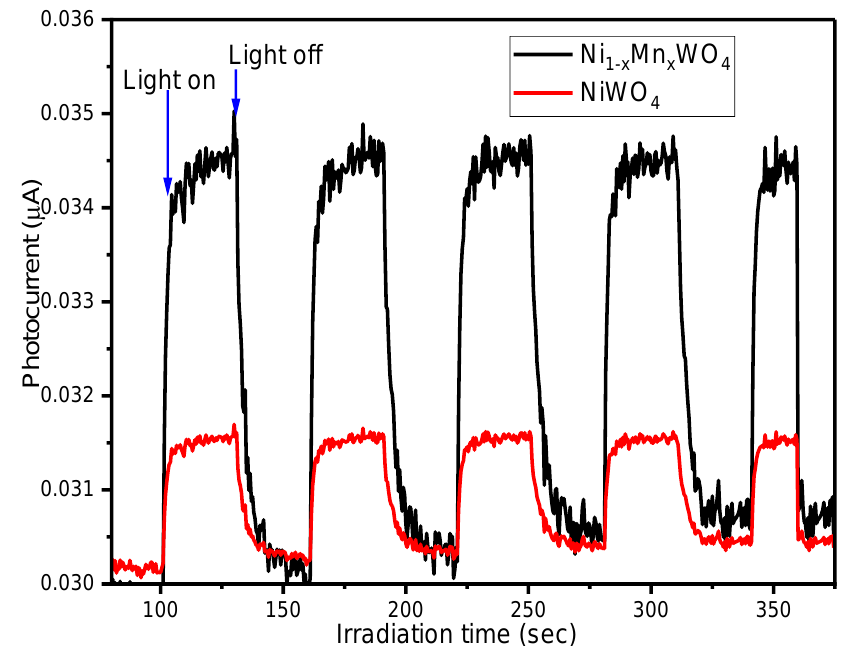
Figure 12. Photocurrent spectra for NiWO 4 and Ni 1 − x Mn x WO 4 NC obtained at 1.3 V.